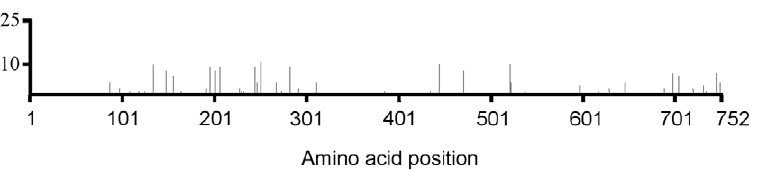
Figure 6. Comparison of gene expression detected by microarray analysis and using real-time RT-PCR (TaqMan). RT-PCR results were obtained using independent blood samples from donor A (TaqMan A) and donor B (TaqMan B) for co-cultivation experiments. Error bars were calculated from three independent biological replicates.